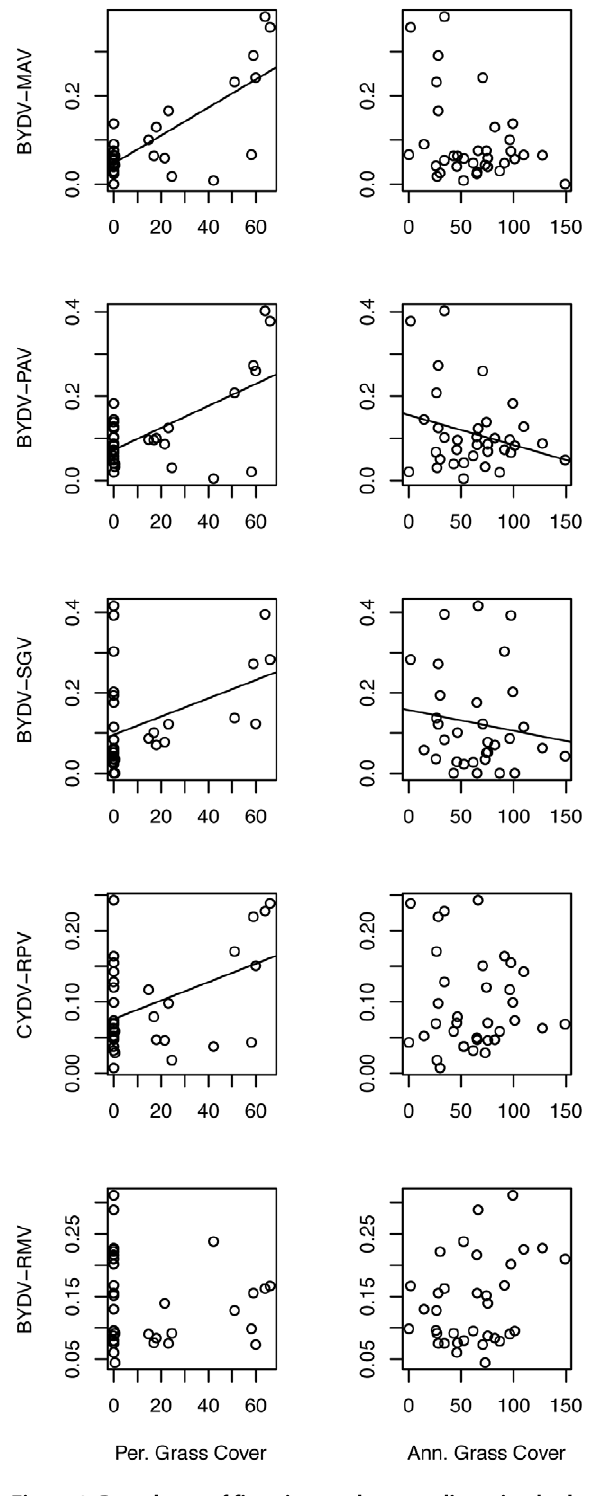
Figure 3. Prevalence of five viruses along gradients in plot host community composition. Lines indicate the slope of significant relationships.